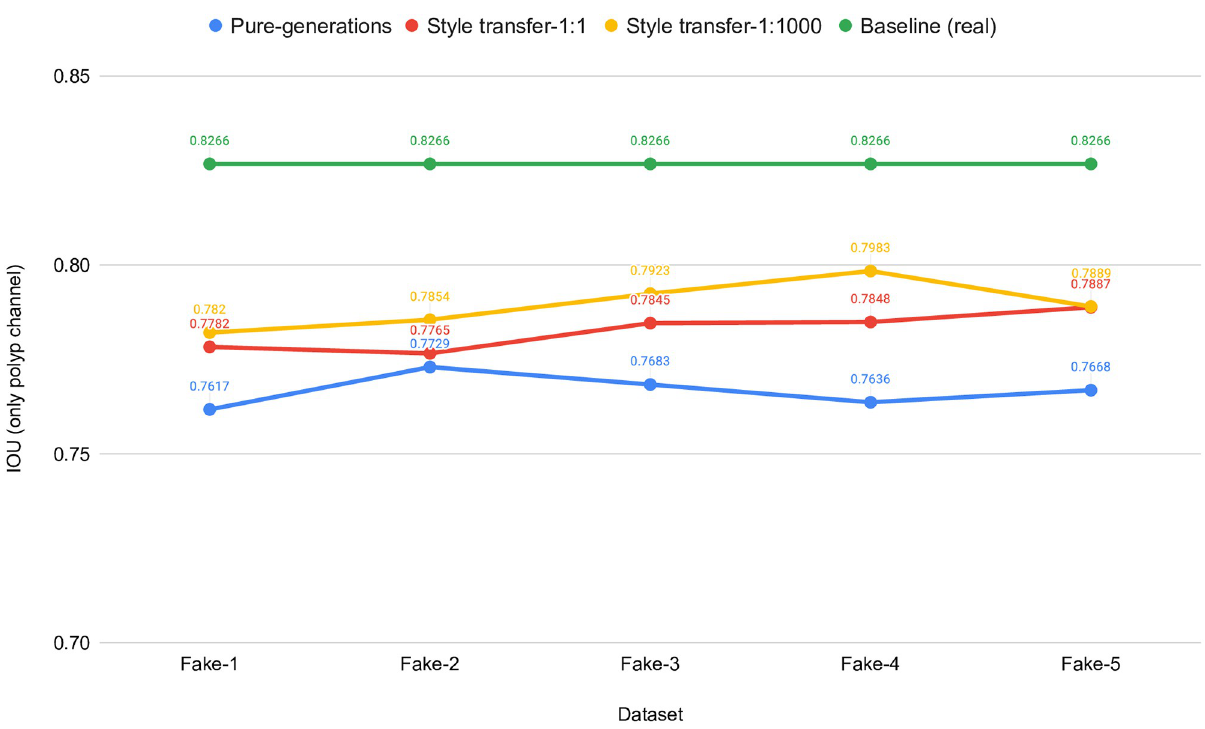
Fig 9. Real versus synthetic data performance comparison with UNet++ and the effect of applying the style-transferring post processing. Note that Y-axis starts from 0.70 for better visualization of differences.